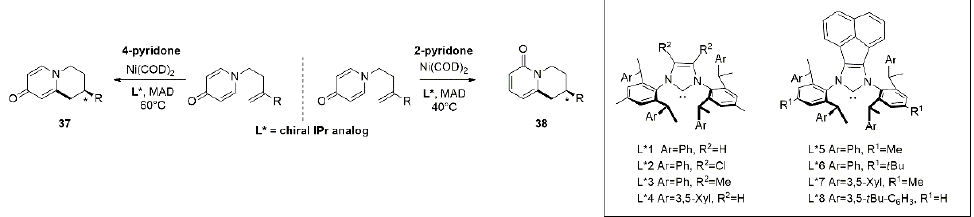
Figure 21 . Chiral and sterically hindered N- heterocyclic carbenes as ligands in the synthesis of 2- and 4-tetrahydroquinolizinones ( 37 and 38 ).